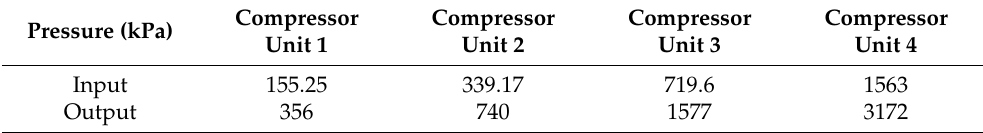
Table 1. Inlet and outlet pressure in the compressor units.